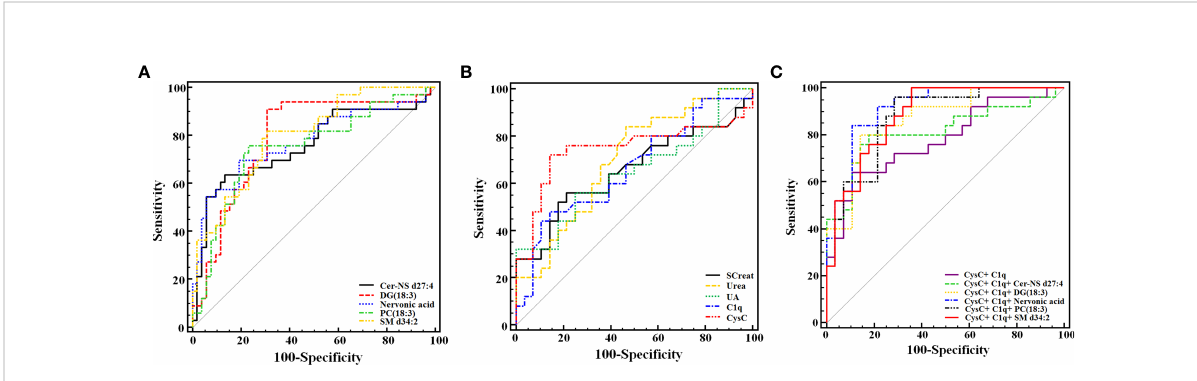
FIGURE 5 Receiver operating characteristic analysis of the 5 newly found candidate biomarkers (A) , and 5 conventional serum renal function markers (B) for discriminating LN from SLE. (C) Joint diagnostic performance of CysC, C1q and newly identi fi ed metabolites. DG (18:3(9Z,12Z,15Z)/20:5